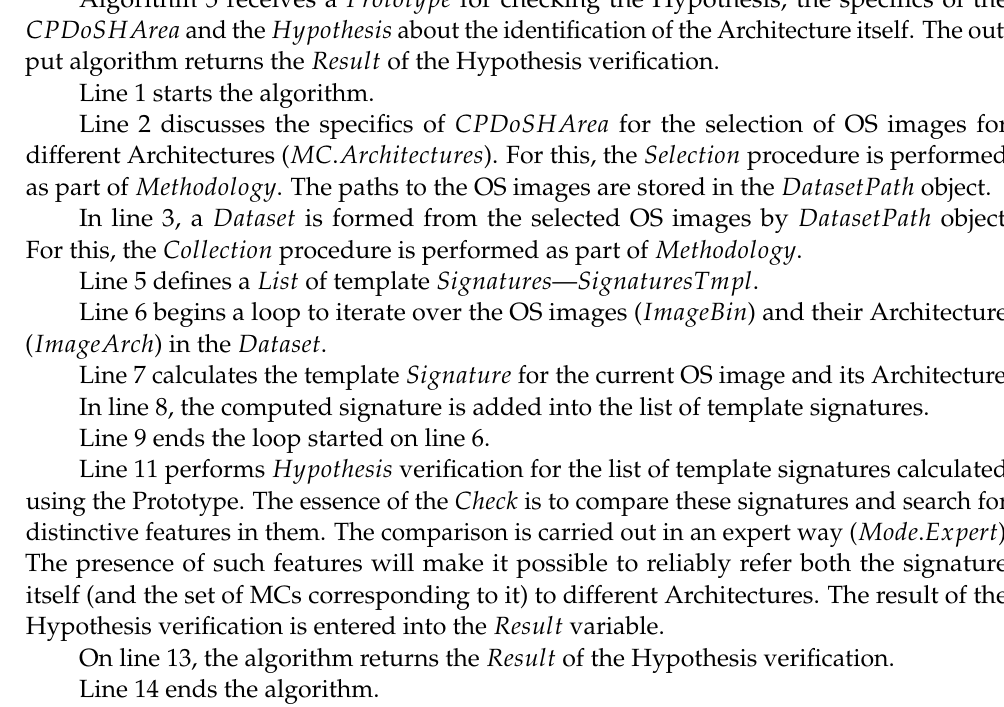
Algorithm 5 receives a Prototype for checking the Hypothesis, the specifics of